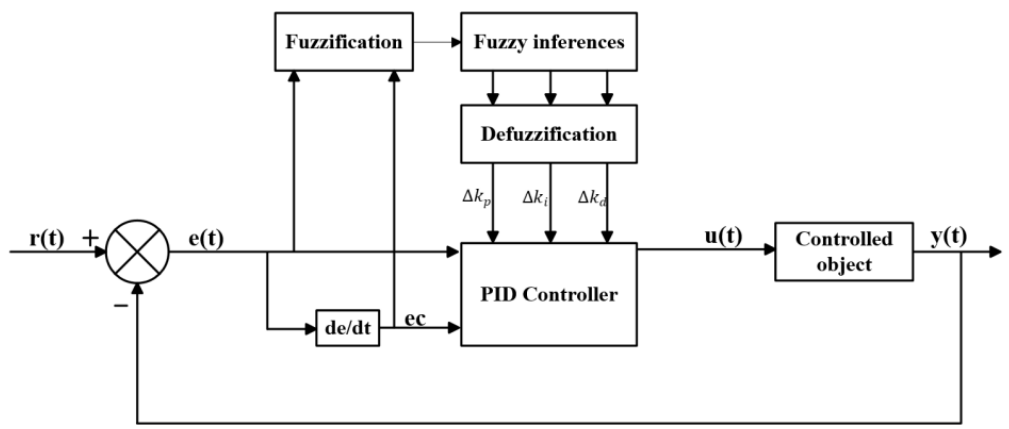
Figure 12. Principle of fuzzy-PID control system.